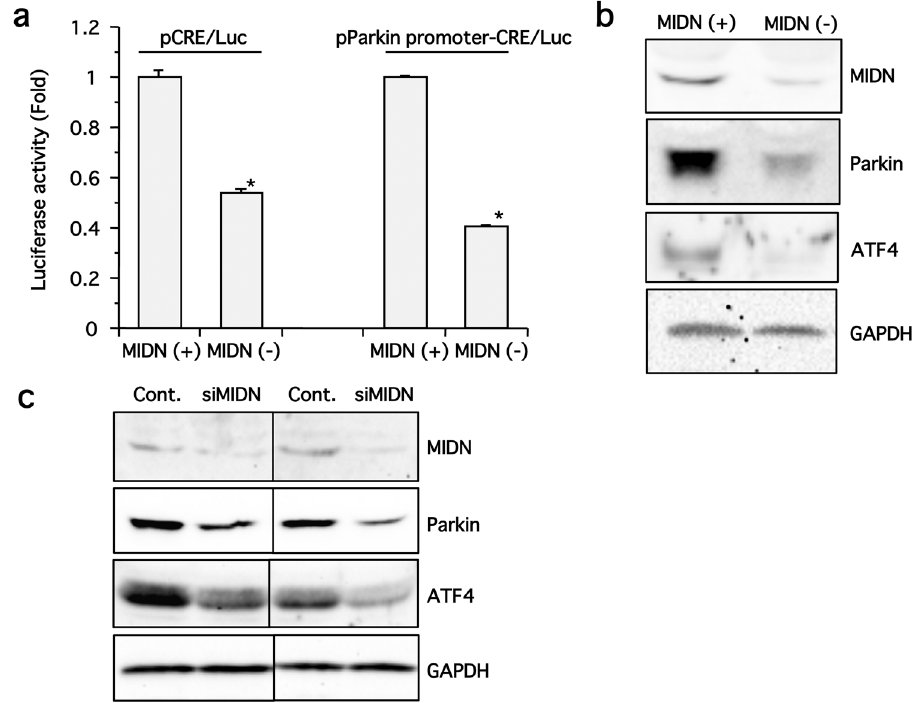
Figure 6. MIDN regulates parkin expression via ATF4 in PC12 cells. ( a ) MIDN-positive and -negative PC12 cells were transfected with DNA plasmids encoding either a typical CRE/luciferase or a human parkin promoter-derived CRE/luciferase, then CRE activity was examined by measuring luciferase activity. In both cases, CRE activity differed significantly between MIDN-positive and -negative cells ( * p < 0.05, n = 3). (b) MIDN, parkin, ATF4, and GAPDH protein levels in MIDN-positive ( + ) and -negative ( − ) PC12 cells were examined by Western blotting. (c) PC12 cells were transfected with 150 pmol of either control siRNA or MIDN siRNA and cultured for 3 days, then protein expression levels of MIDN, parkin, ATF4, and GAPDH were examined by Western